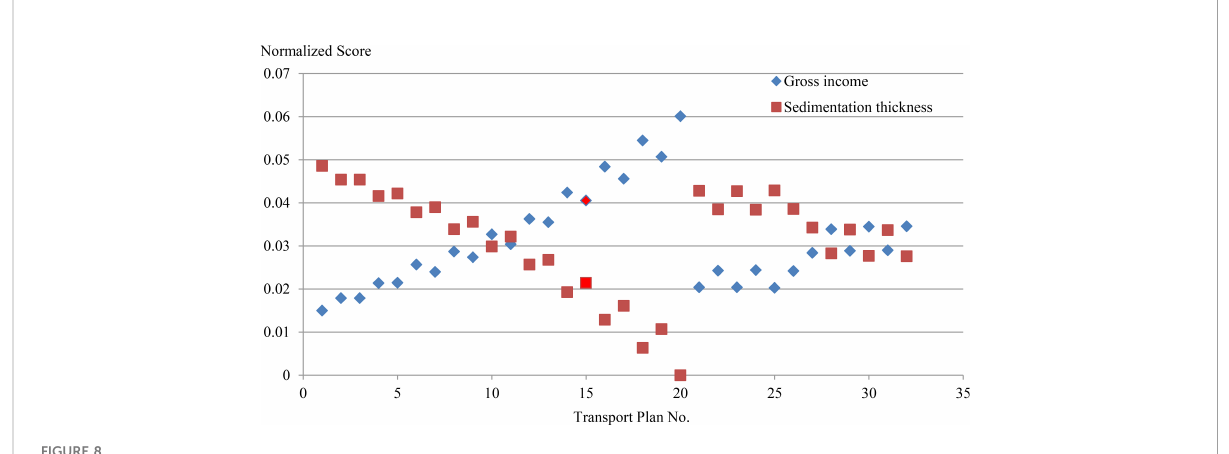
FIGURE 8 Normalised scores of gross income and sedimentation thickness. The red points represent the most preferable and sustainable DSM transport